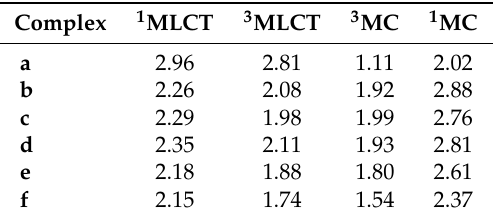
Table 1. Vertical excitation energies (in eV) of the six Fe(II) complexes with ligands of increasing size. Complex 1 MLCT 3